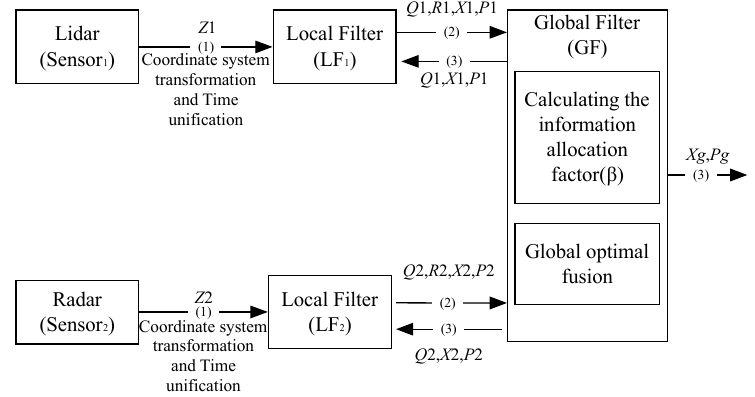
Figure 1. The structure and working process of JAKF.